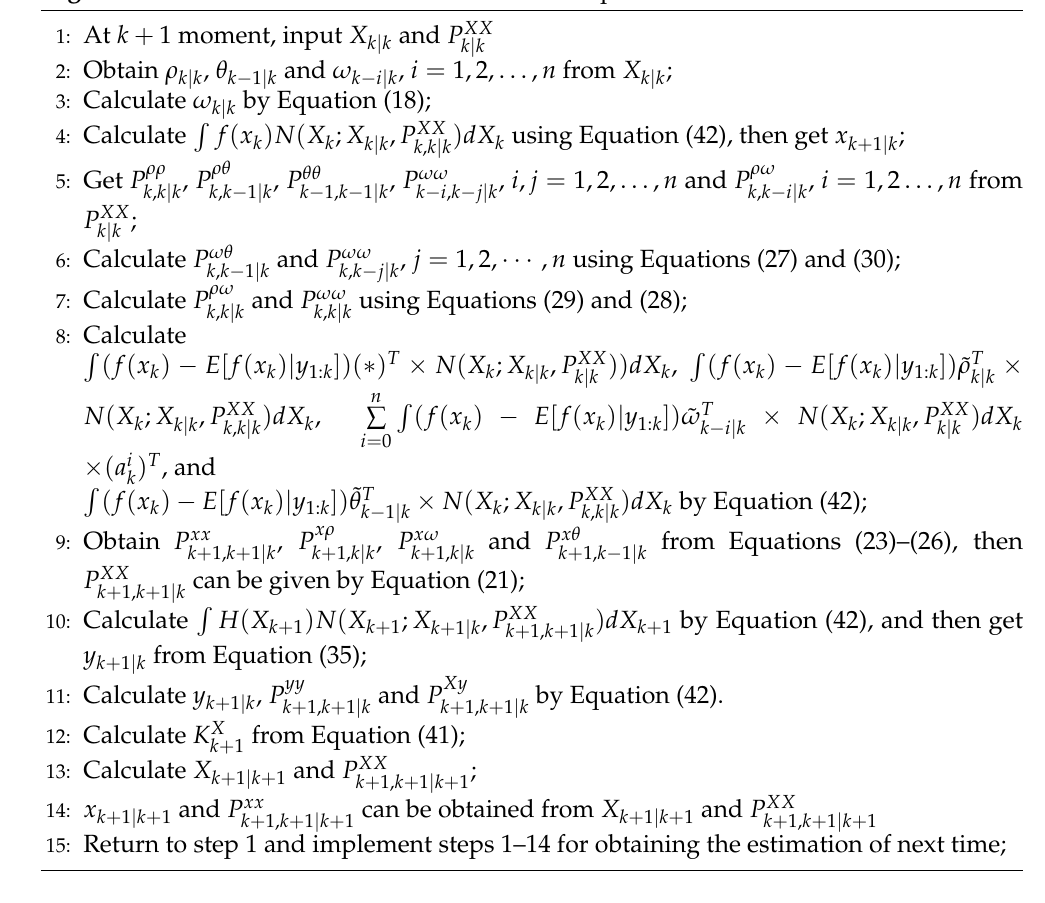
Algorithm 1 Cubature Kalman filter with multi-step colored